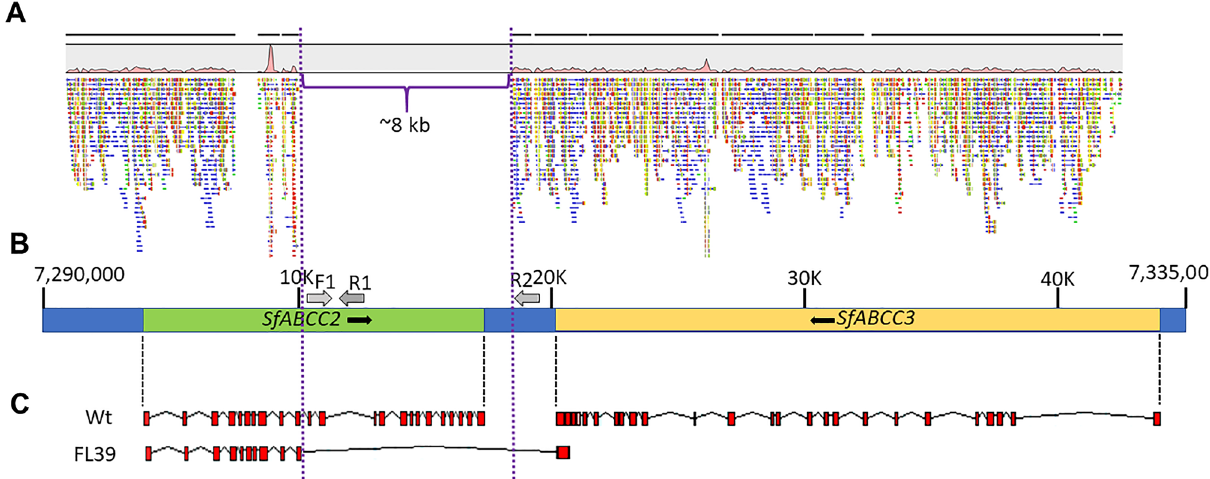
Figure 2. Diagram representing the genomic deletion in the SfABCC2FL1R allele. ( A ) Representative diagram of raw sequences mapping to the locus containing the SfABCC2 and SfABCC3 genes (Scaffold 33, nucleotides 7,290,000 to 7,335,000 in the S. frugiperda corn host strain genome v.6.0 38 ) from sequencing the genome of larvae from the FL39 strain. The ~ 8 kb genomic region missing in the SfABCC2FL1R allele is delimited with purple dashed lines and open brace. ( B ) Diagram showing the SfABCC2 and SfABCC3 ORFs. Black arrows next to the gene names indicate that the genes are transcribed in opposite direction. Grey arrows represent the priming sites for a common primer (F1) and reverse primers specific to the wild type SfABCC2 (R1) and SfABCC2FLR1 (R2) alleles, respectively, that were used in discriminative PCR genotyping reactions. ( C ) Predicted exons (red) and introns (connecting lines) in the SfABCC2 and SfABCC3 genes in wild type (Wt), and Cry1F-resistant (FL39) strains. Dashed black lines indicate the relative location of the predicted transcripts for each gene in ( B